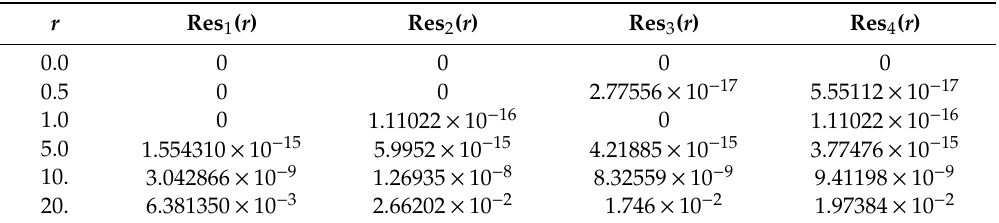
, i = 1,2,3,4 ) for the results obtained by i